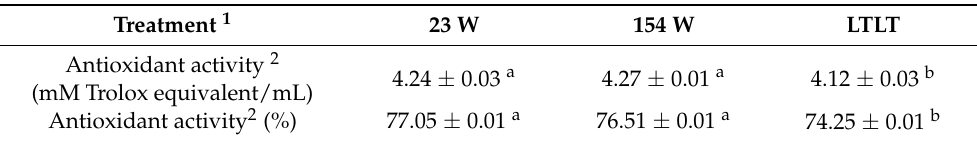
Table 3. Effect of ultrasound power and pasteurization on the antioxidant activity of whey–oat beverages (mean ±